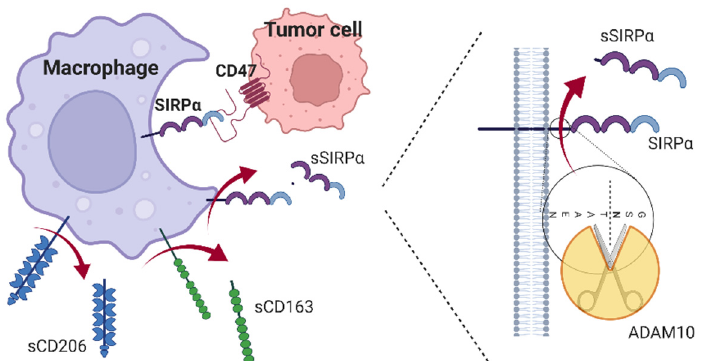
Figure 1. CD47 on tumor cells protects against phagocytosis. It interacts with SIRP α on the surface of TAMs resulting in decreased macrophage phagocytic capacity. Activation of macrophages leads to shedding by metalloproteases of soluble receptors (sCD163, sCD206) that function as biomarkers of macrophage activation in the blood. Soluble SIRP α (sSIRP α ) is thought to be the product of extracellular domain shedding by the action of ADAM10 that, upon activation, cleaves SIRP α at a juxta-membrane position (15). Created with BioRender.com.